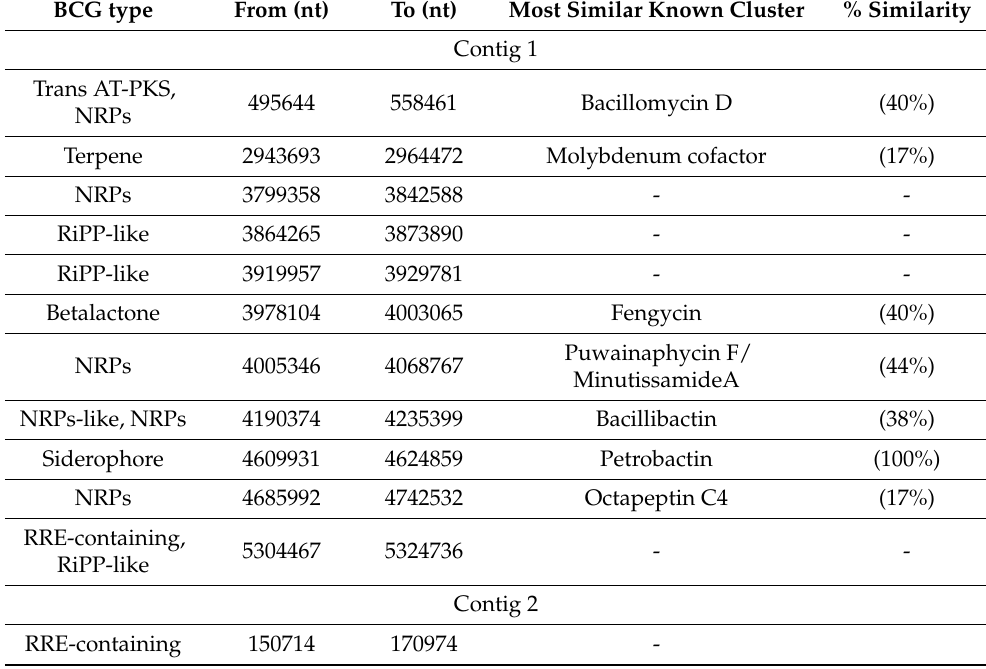
Table 4. Biosynthetic gene clusters identified using AntiSMASH. Nucleotide positions within the genome are